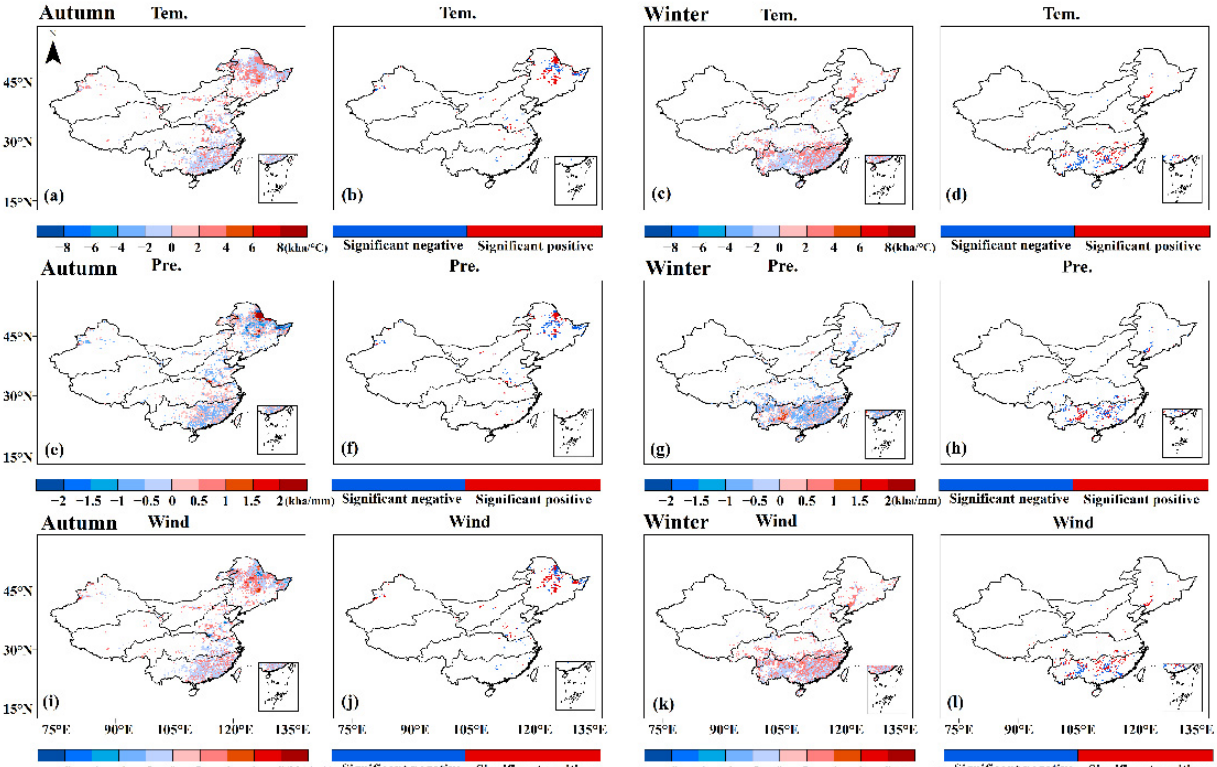
Figure 13. The coefficients of the multivariable regression equations between BA and three climatic factors (i.e., temperature, precipitation and wind speed) in autumn and winter. The first and third columns show all points in autumn and winter, respectively, and the second and fourth columns show the corresponding significant points ( p < 0.1) in autumn and winter, respectively: ( a – d ) represent temperature; ( e – h ) represent precipitation; ( i – l ) represent wind.